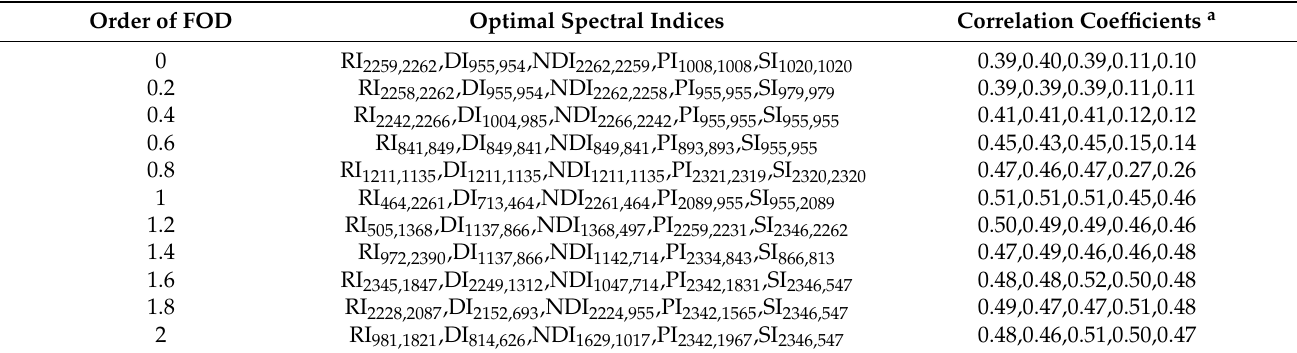
Table 3. The bands and correlation coefficient of optimal spectral indices for